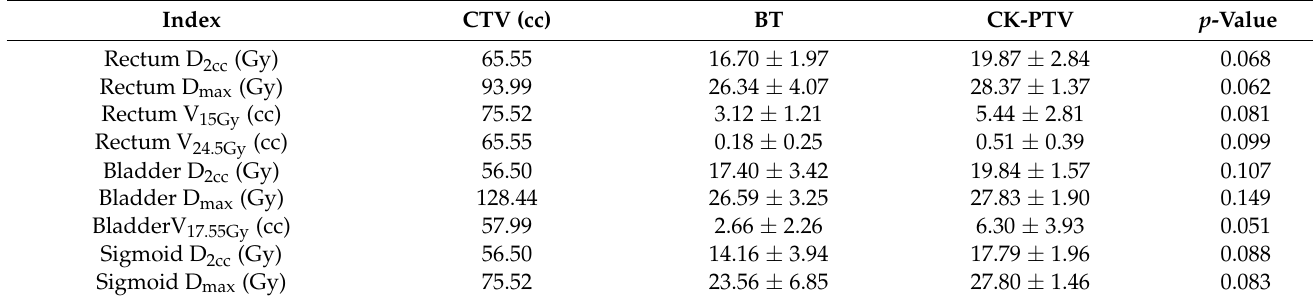
Table 5. Relationship between CTV and tolerance doses for OARs in the BT and CK-PTV